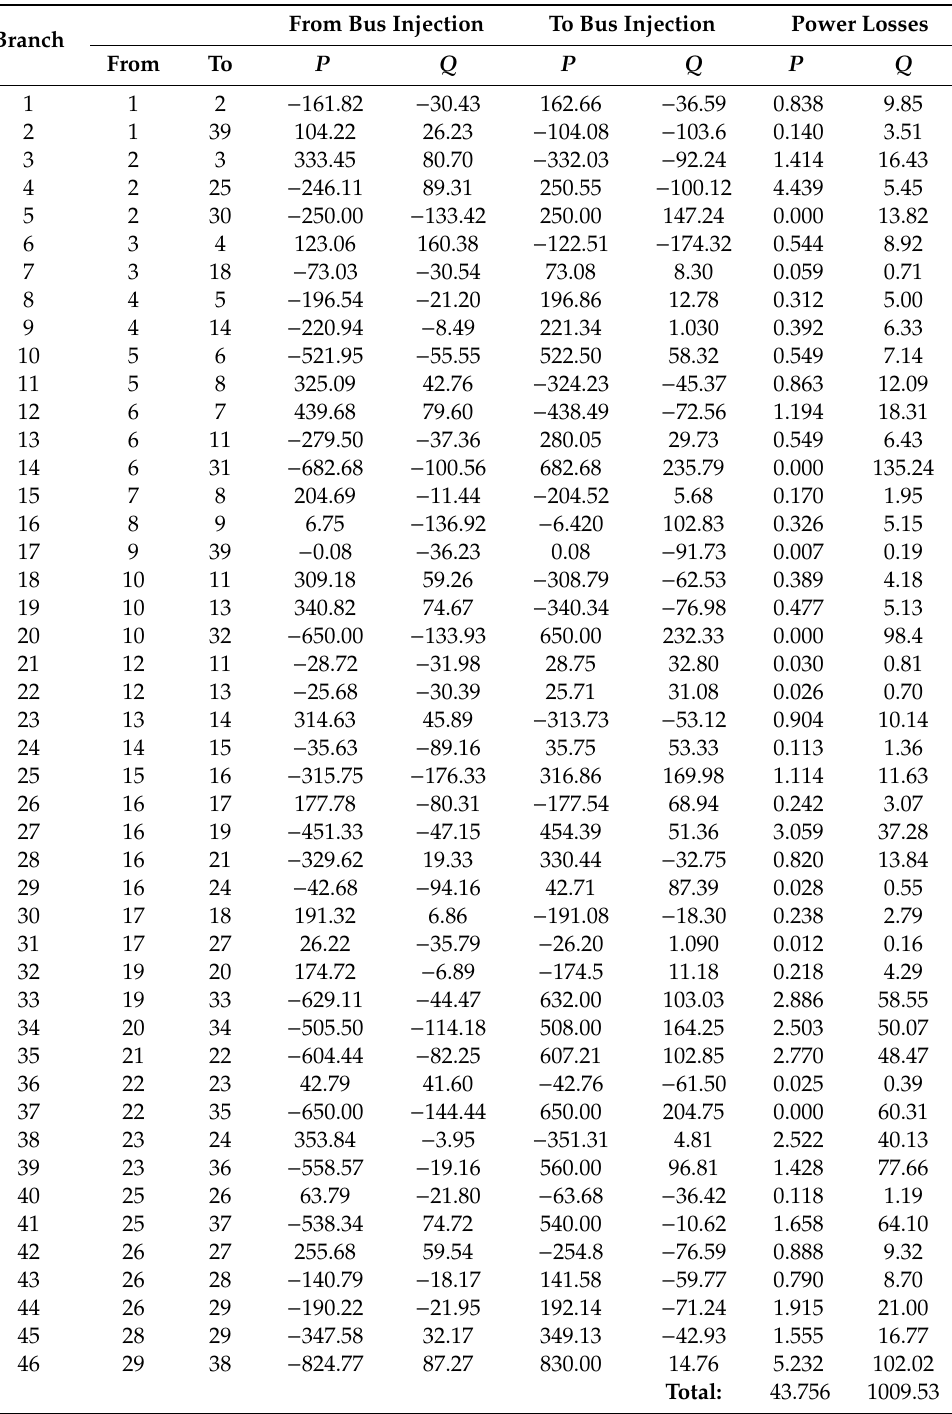
Table A36. Results of Mixed AC / DC PF calculations in Case 7-2. AC branch